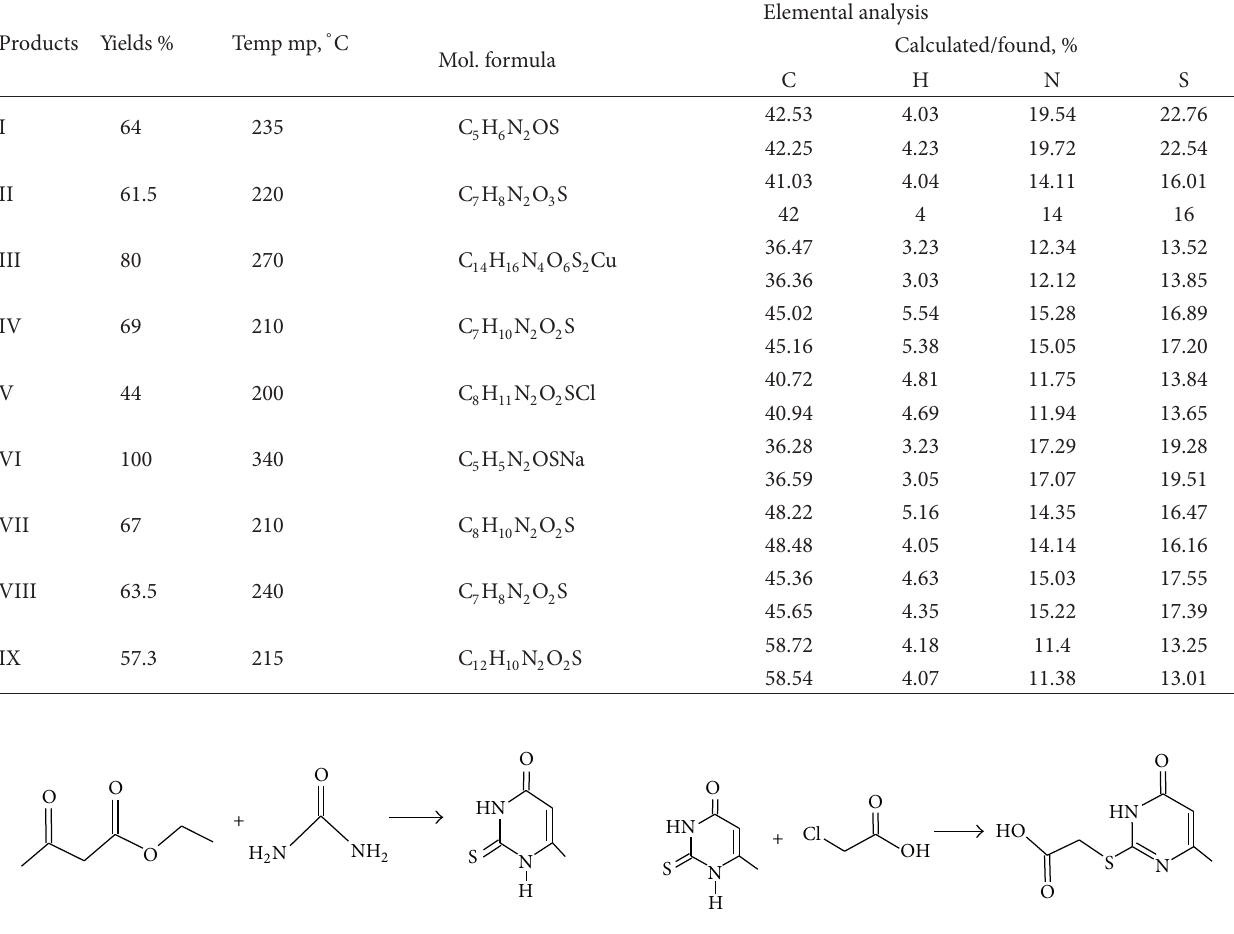
F 1: Syntheses of 2,3-dihydro-6-methyl-2-thioxopyrimidin-